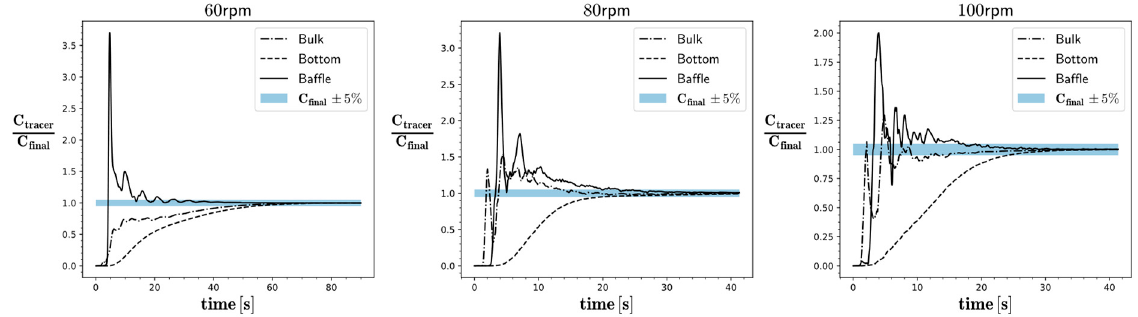
Figure 13. Normalised tracer concentration profiles at three rotational speeds probed at three different locations.